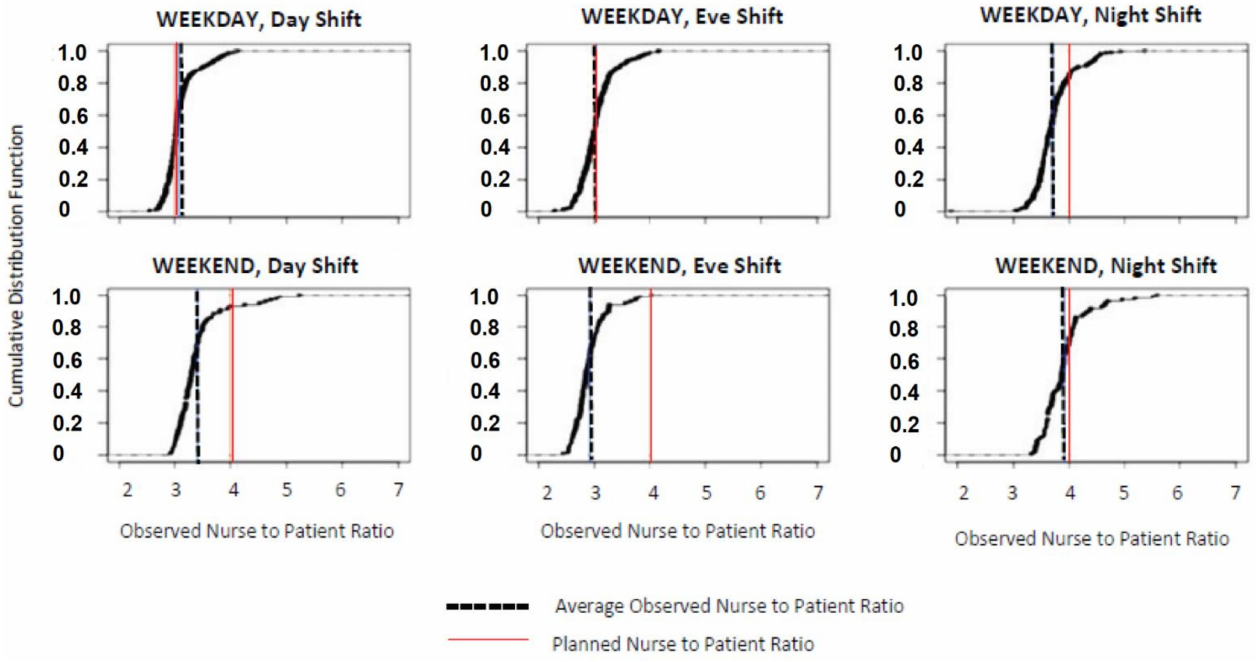
Figure 9. Nurse-to-patient ratios, actual and norms by shift and by